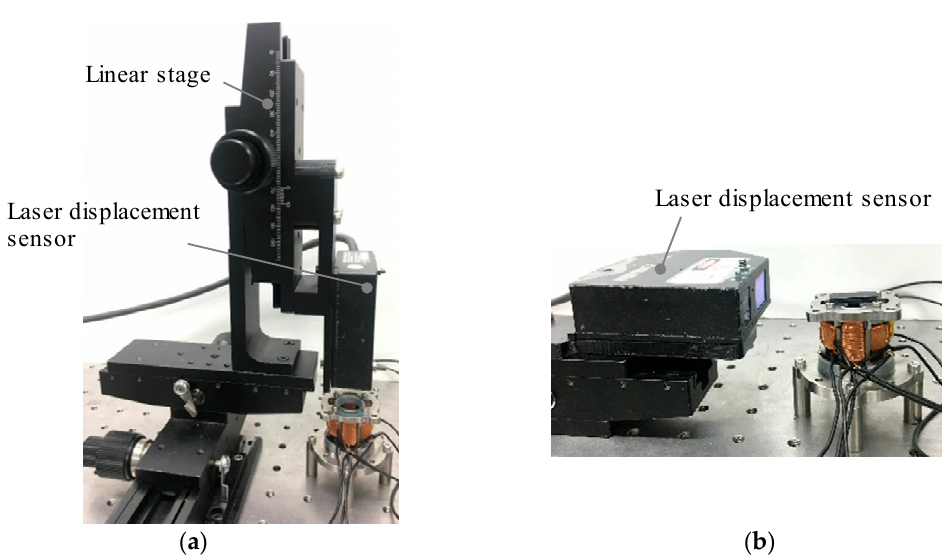
Figure 17. Experimental setup of the frequency characteristics. ( a ) Rotation in the X -axis; ( b ) Rotation in the Z -axis.